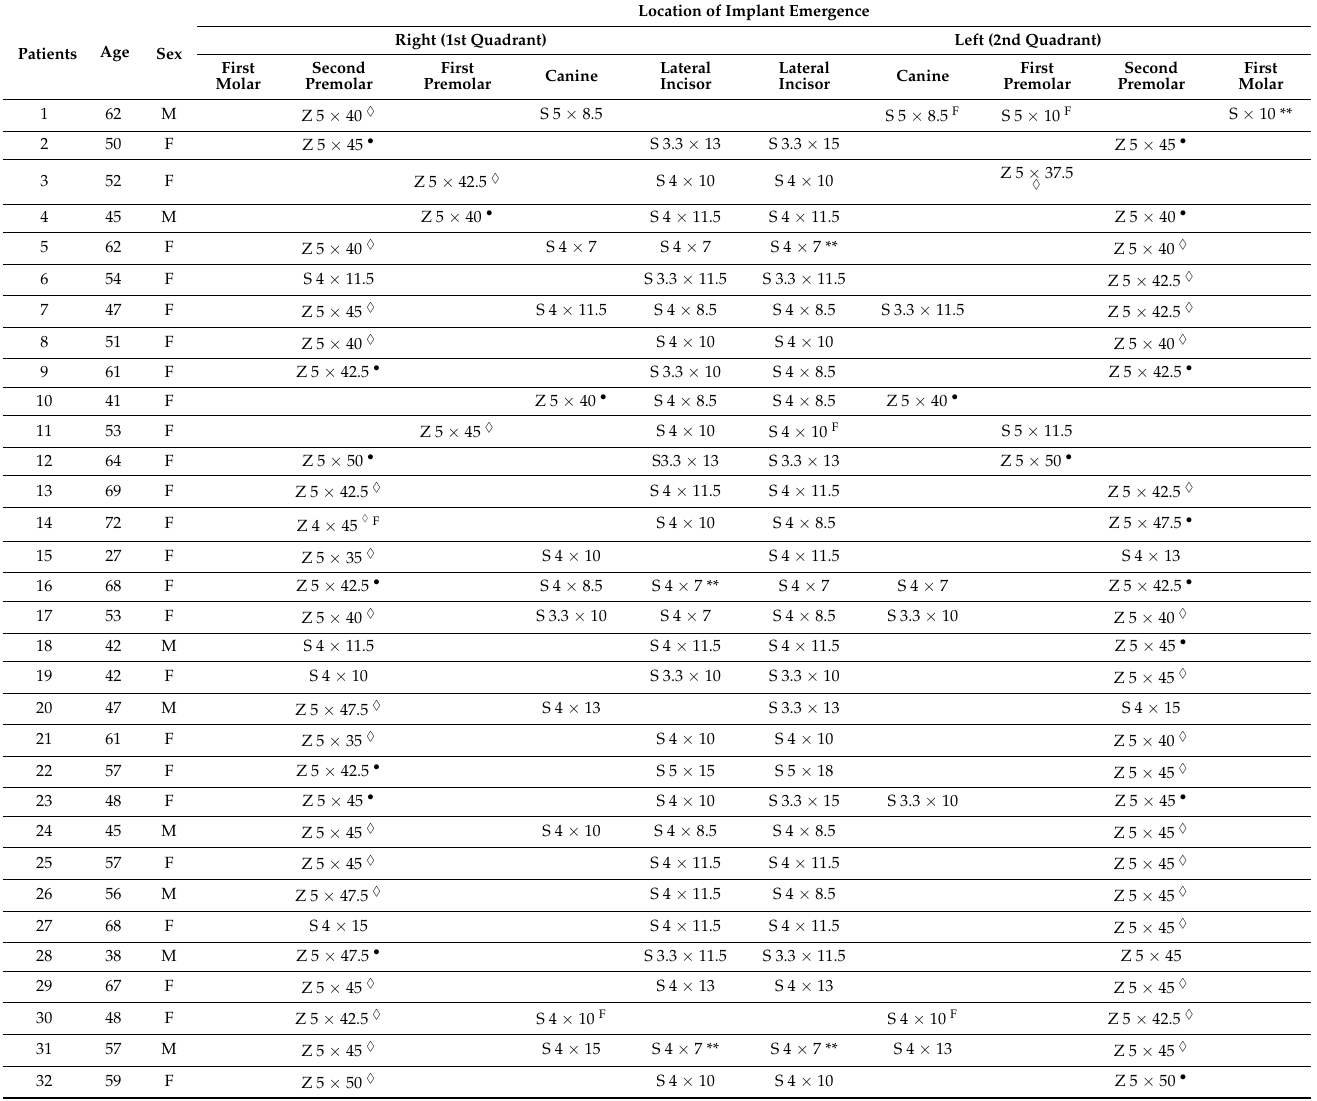
Table 1. Study population: Implant type, position of emergence and loading